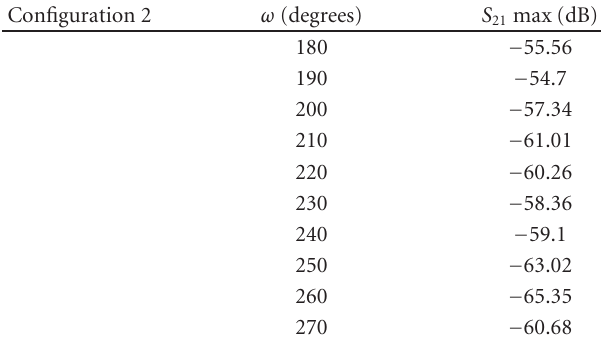
ω = 200 ◦ . (b) S ω = 200 ◦ . 21 for